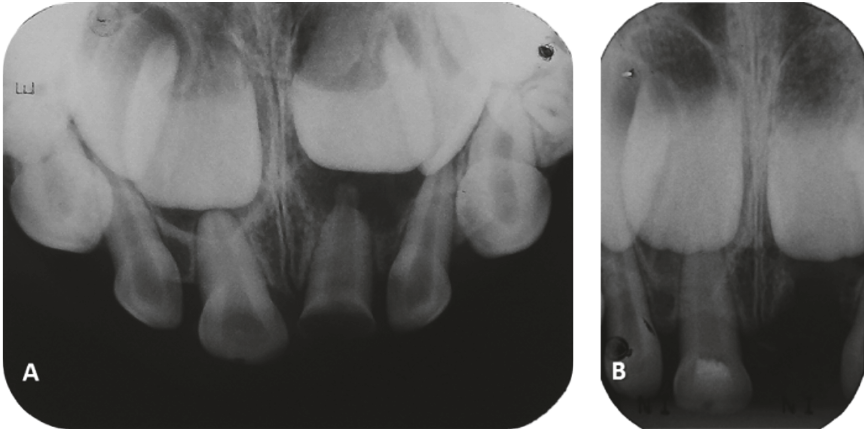
Figure2:(A)Theinitialperiapicalradiographyshowingnoperiapicalalterationsin (51) andlesionin (61) withdisruptionofthedentalfollicle of the permanent left maxillary central incisor (21) . (B) The periapical radiography after the pulpotomy of tooth (51) and the extraction of (61) .